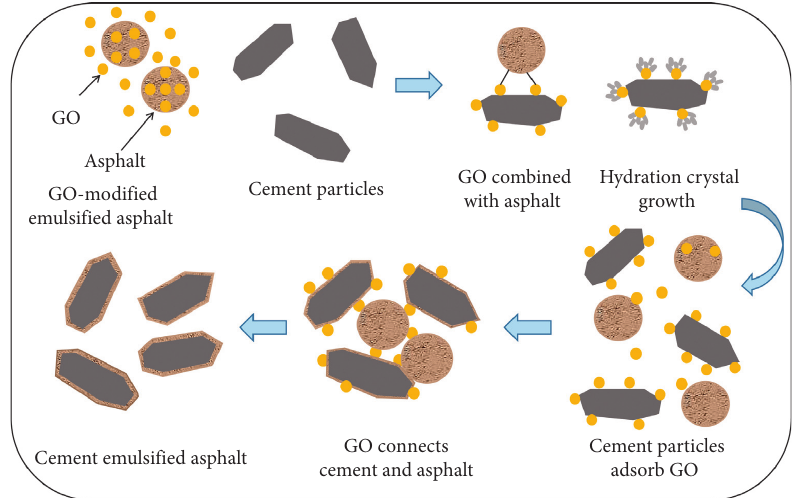
Figure 8: Diagrammatic sketch of absorption in CEAP.